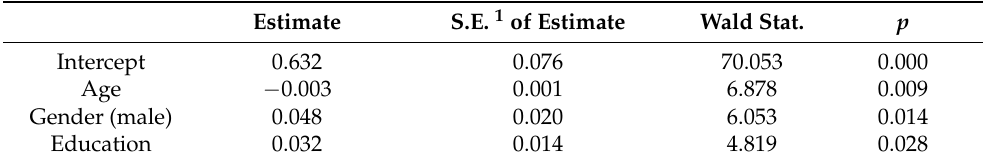
Table 3. Estimates of parameters—residents, PV plants.